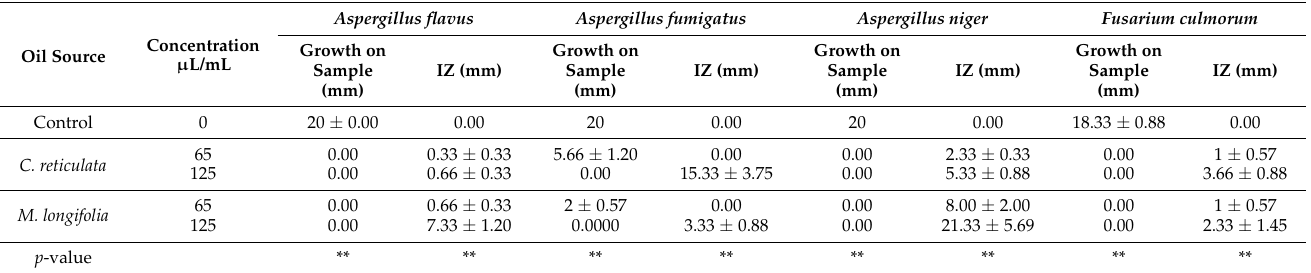
Figure 2. Experimental application of essential oils from Mentha longifolia and Citrus reticulata to Pinus halepensis wood and the visual observation of growth of A. flavus , A. niger , A. terreus , and F. culmorum . Table 5. Growth on wood samples ** and inhibition zones ** (mm) of A. flavus , A. niger , A. terreus , and F. culmorum , as affected by essential oils from Mentha longifolia and Citrus reticulate.